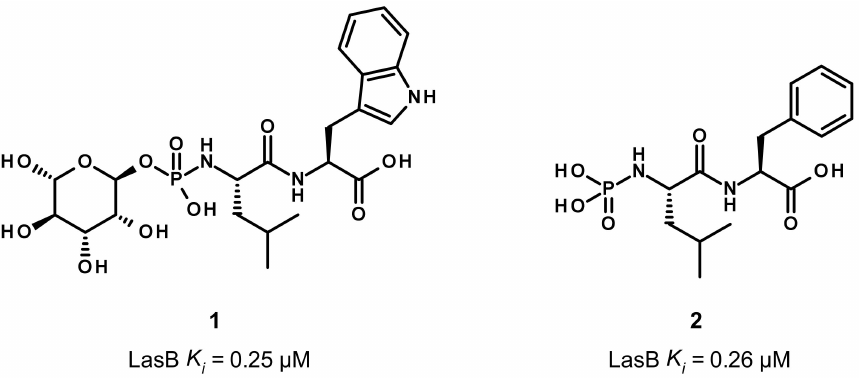
Figure 2. Chemical structures and biochemical activities of phosphoramidon 1 and its analogue 2 . K i values were extracted from the original publication